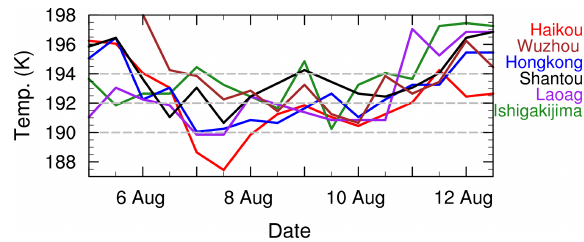
Figure 13. As Fig. 6 but for the case in